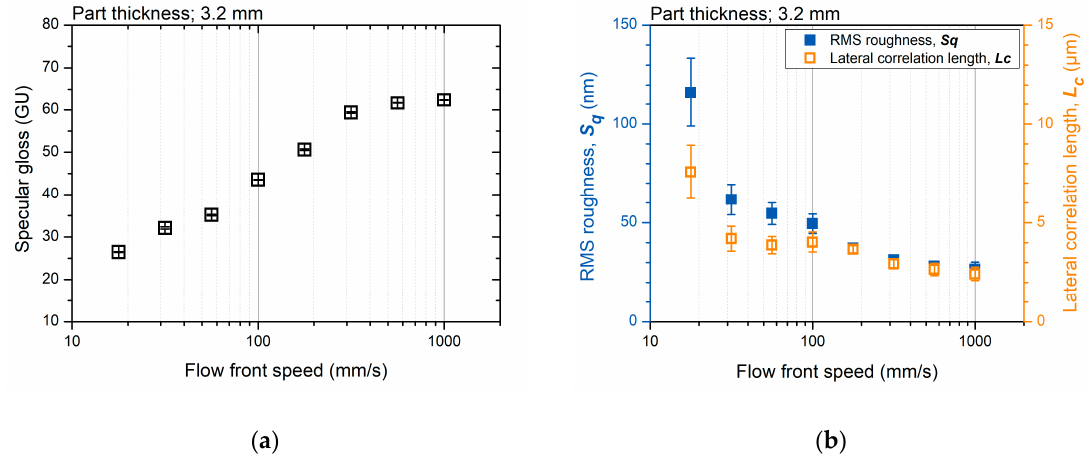
Figure 6. Surface measurement result: ( a ) surface gloss and ( b ) topography parameters.